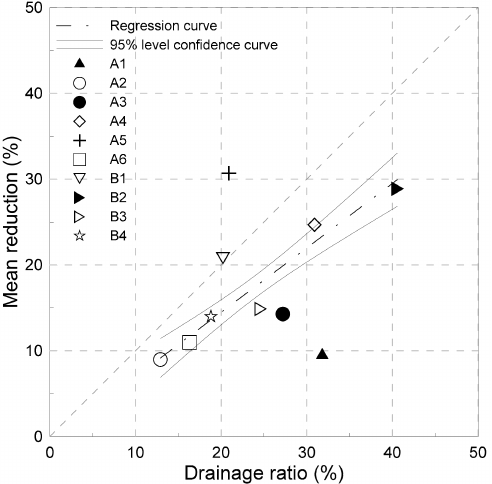
Figure 7. Mean runoff reduction by drainage ratio (drainage area of each sub-basin/LID drainage area × 100%) from the short-term simulation. A5 and B1 were outliers with a relatively high runoff reduction rate while A1, A3, and B3 showed the opposite